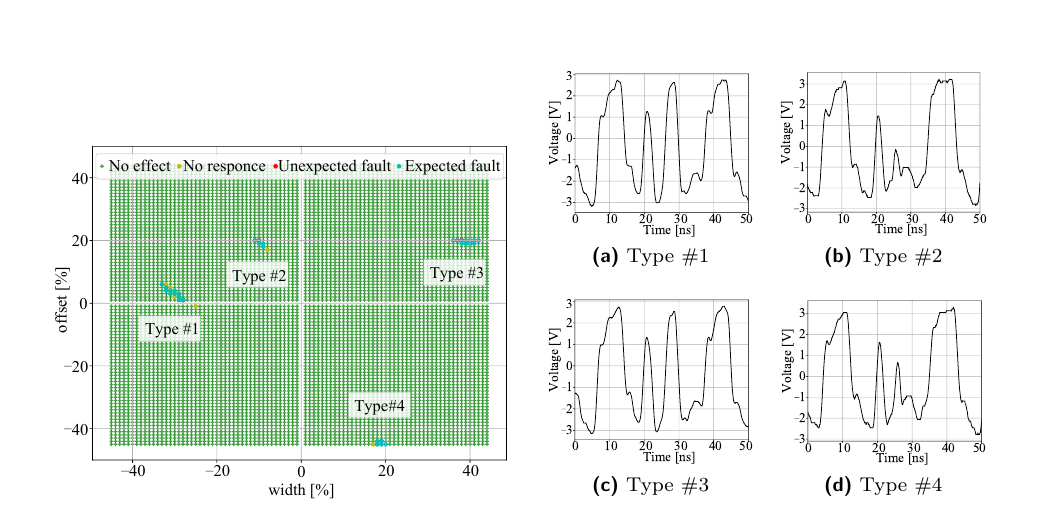
Figure 17: Profiling result for the exploita- tion device.